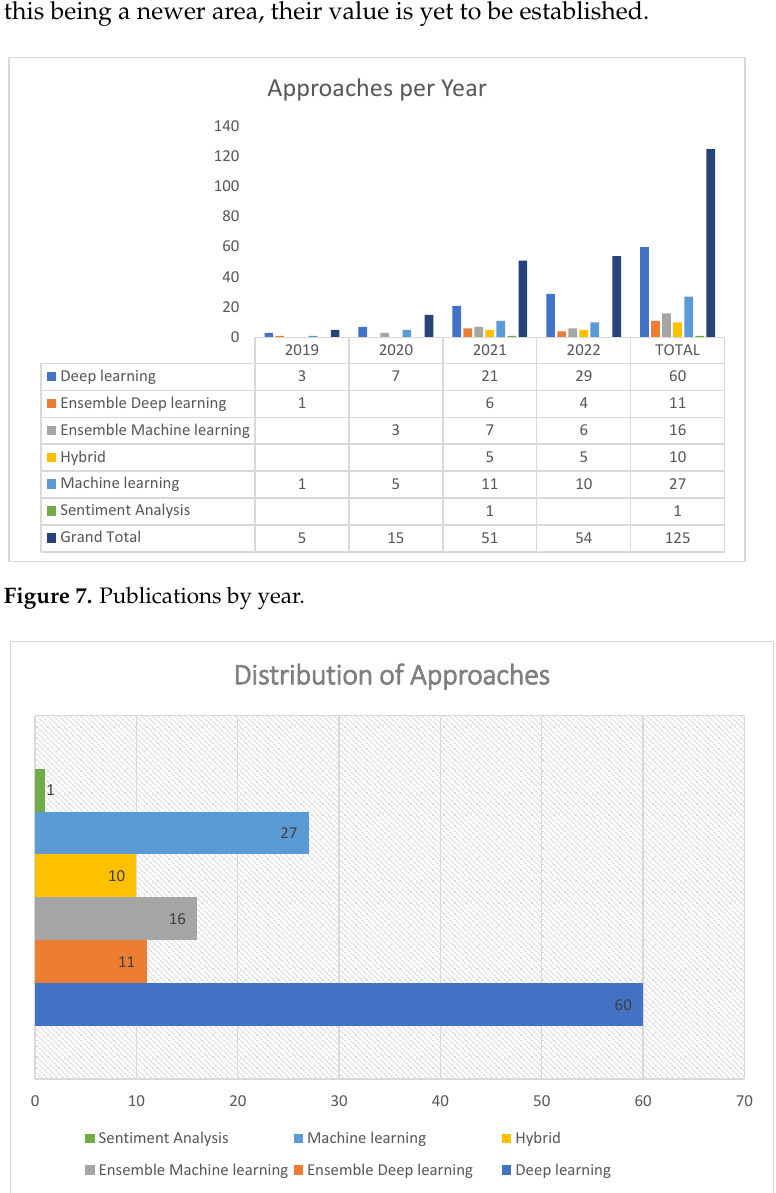
Figure 8. Comparative distribution of approaches.